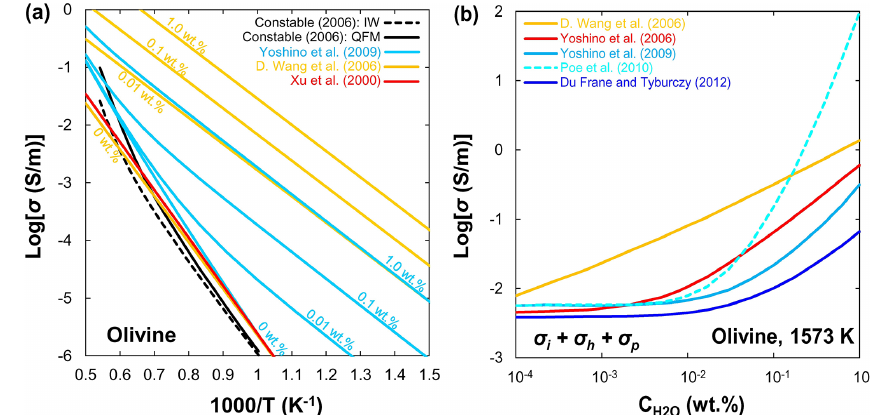
Figure 5. Compilation of electrical conductivity data of olivine aggregates as a function of water content. (a) Log conductivity versus reciprocal temperature. (b) Log conductivity versus water content at 1573K. The number labels indicate water content in weight